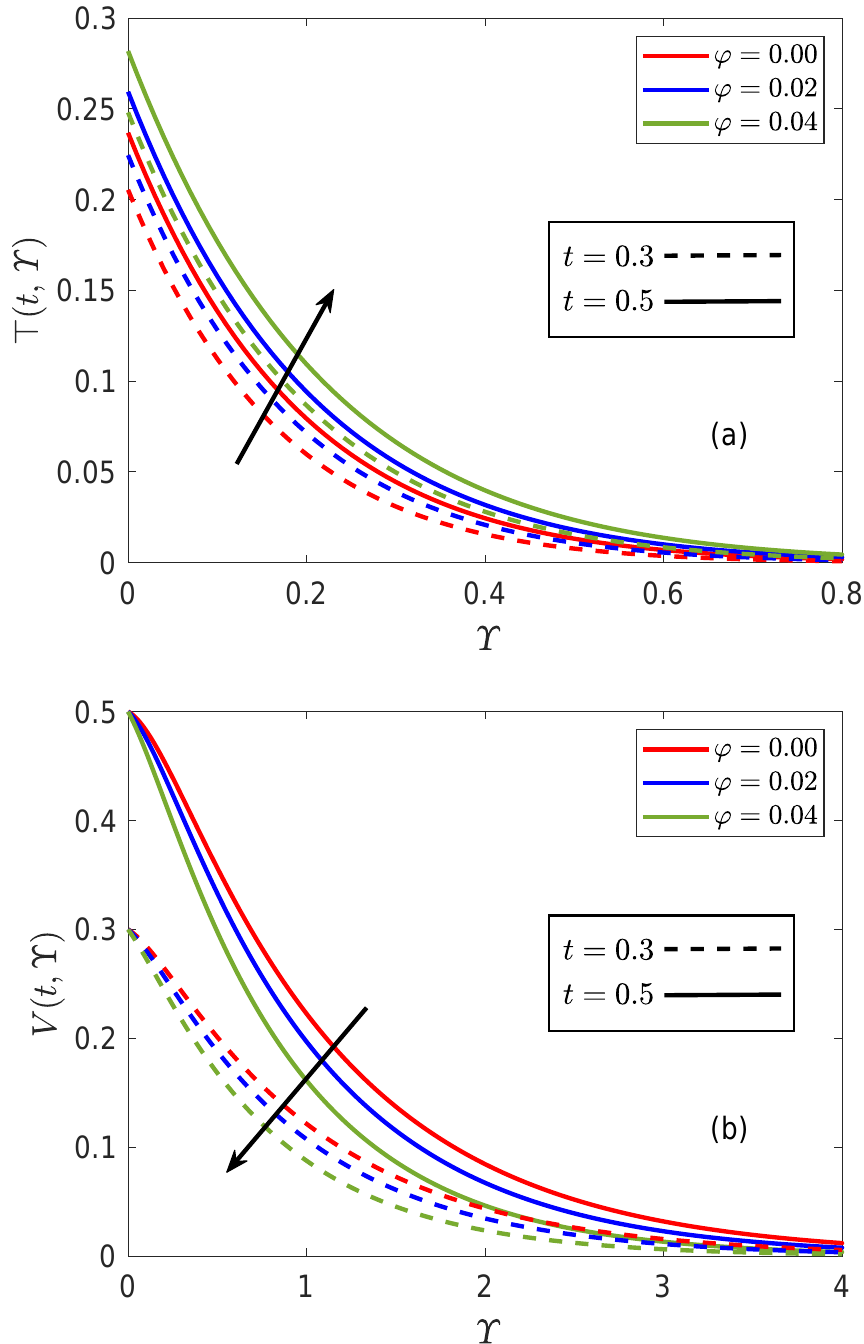
Figure 9. ( a ) Thermal patterns corresponding to variations of ϕ for smaller time inputs. ( b ) Flow patterns corresponding to variations of ϕ for smaller time